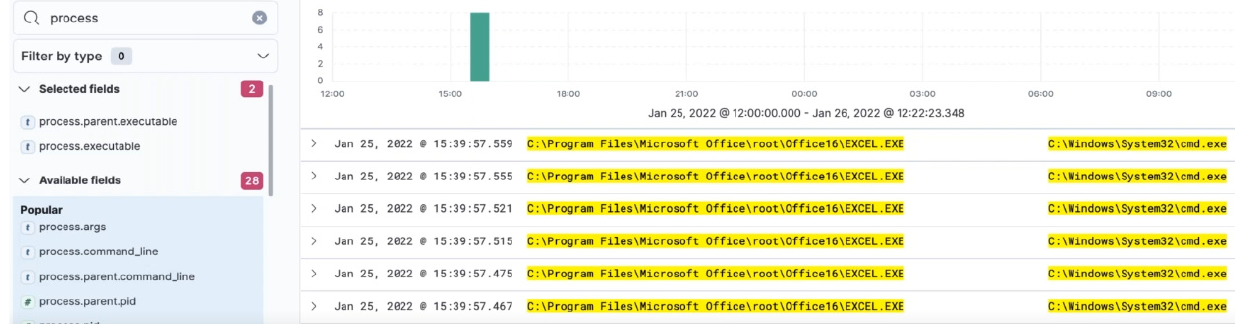
Figure 7. Script search results.